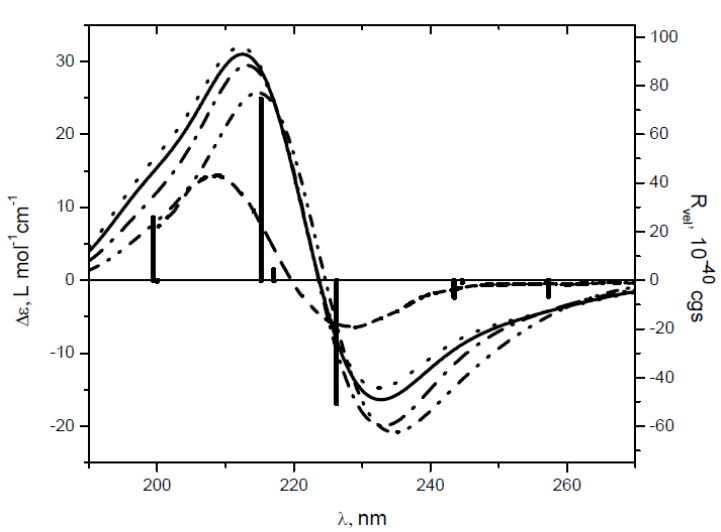
Figure 4. Comparison of experimental (- - ) and theoretical spectra of diacid 4 , calculated at the B3LYP/aug-cc-pVDZ level ( σ = 0.30 eV) for individual conformers ( trans-trans represent the rotatory strength for the most abundant trans-trans